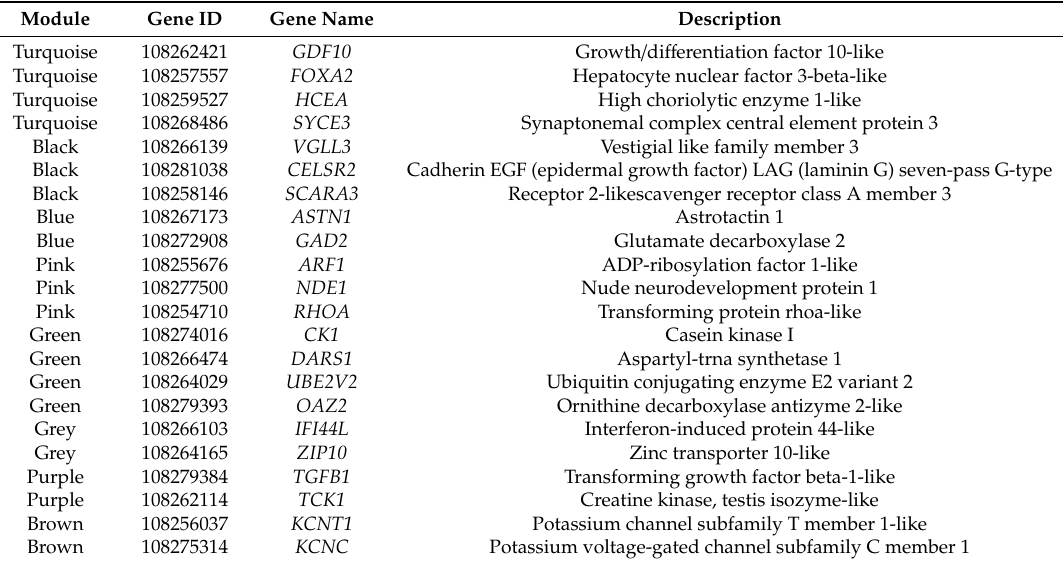
Table 2. List of hub genes in channel catfish development co-expression